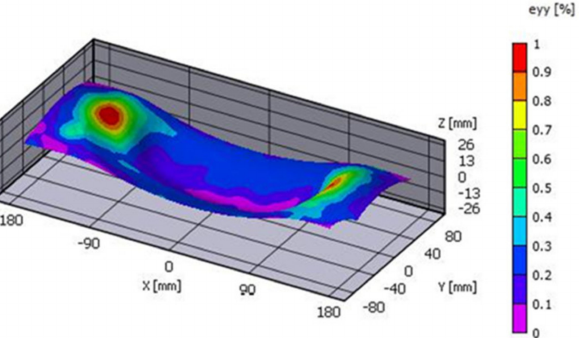
Figure 8. Strain distribution in the y-direction (circumferential) at 6.2 MPa obtained with DIC analysis for Specimen #20.